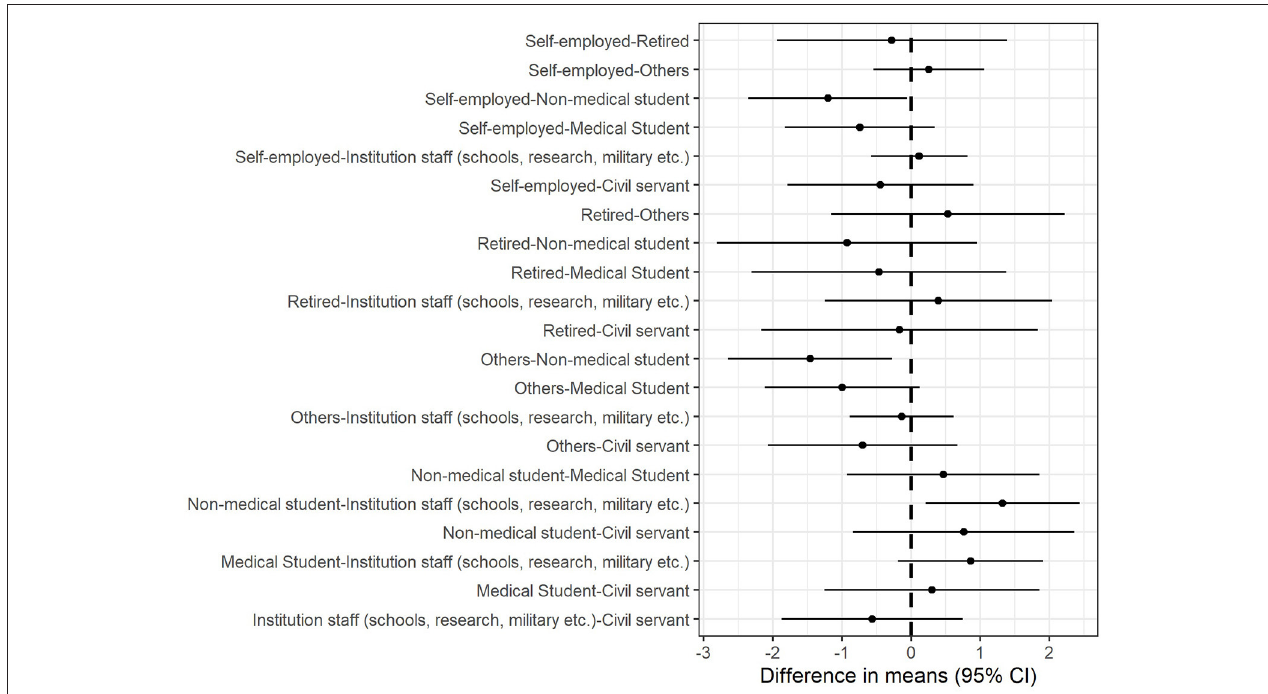
FIGURE 2 | Marginal mean differences in trust for occupational groups. Self-employed persons, institutional staff, and other professionals had lower trust in doctors than non-medical students.